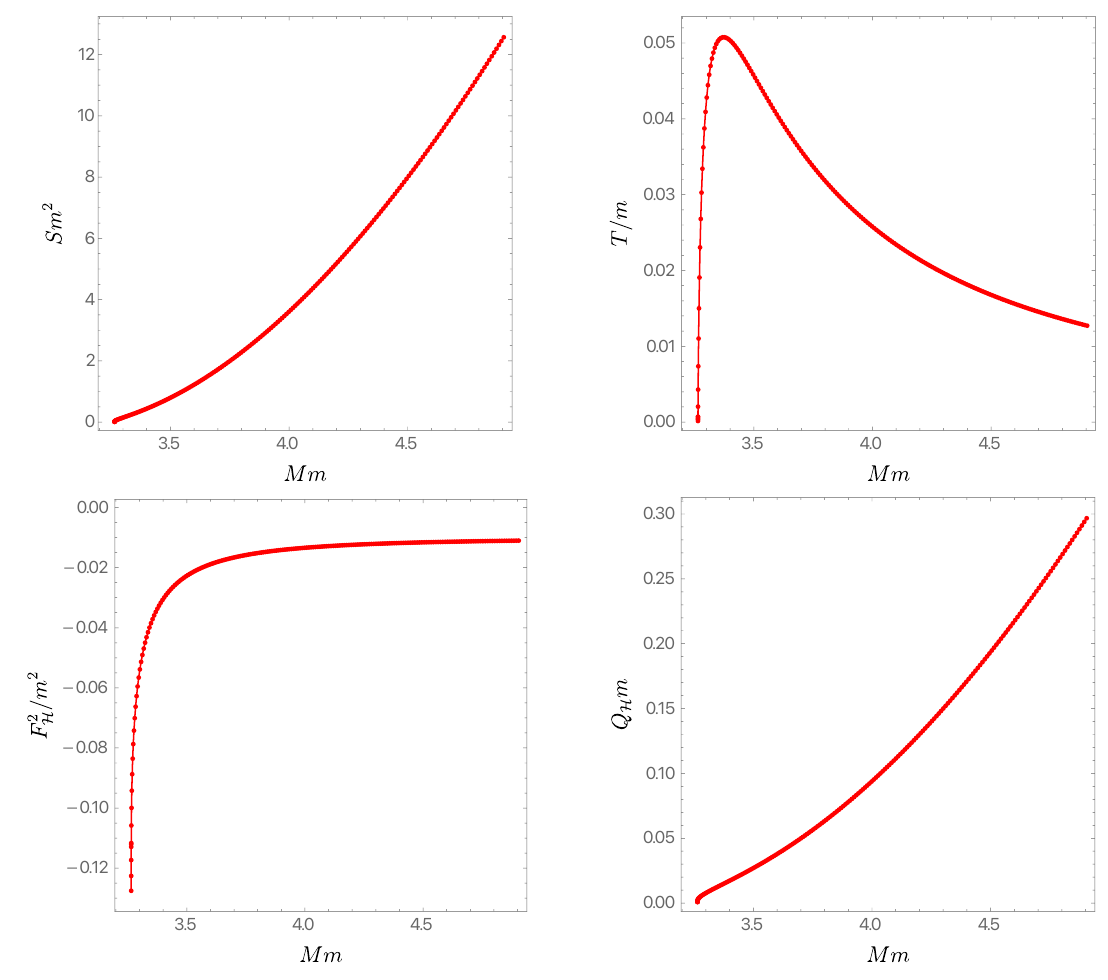
Figure 4 . Physical properties of the maximal warm holes with q = m and α = 100 . Comparing with the α = 1 case of figure 2, we see that increasing α increases the extremal temperature only slightly (top-right panel), but decreases substantially the fraction of the charge carried by the black hole (bottom-right